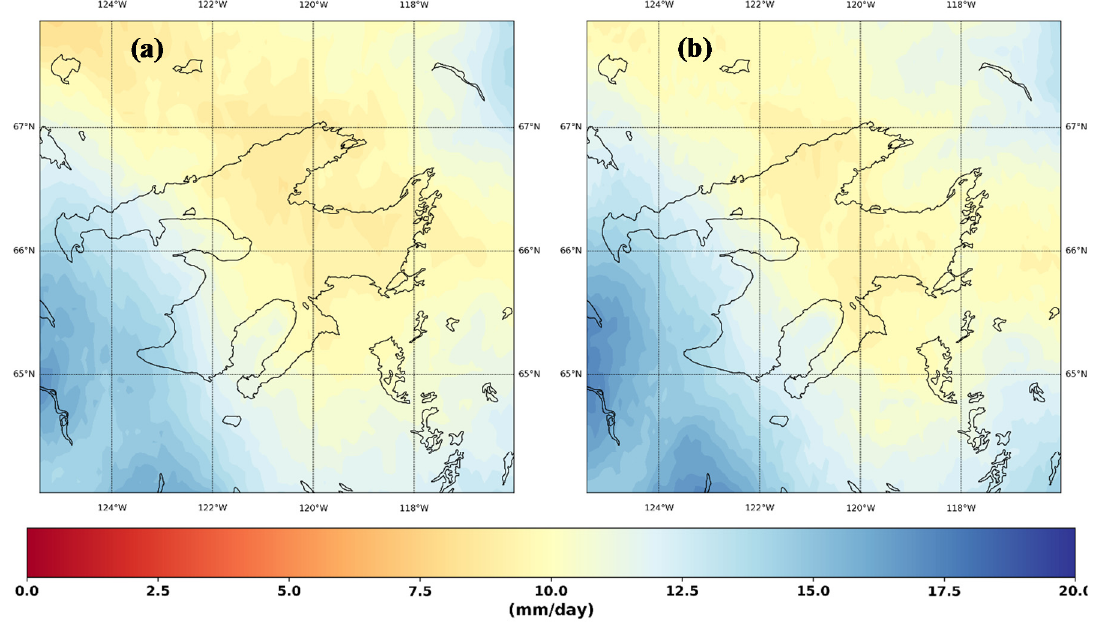
Figure 7. The temporal median of annual maximum precipitation ( a ) observed and ( b ) simulated.